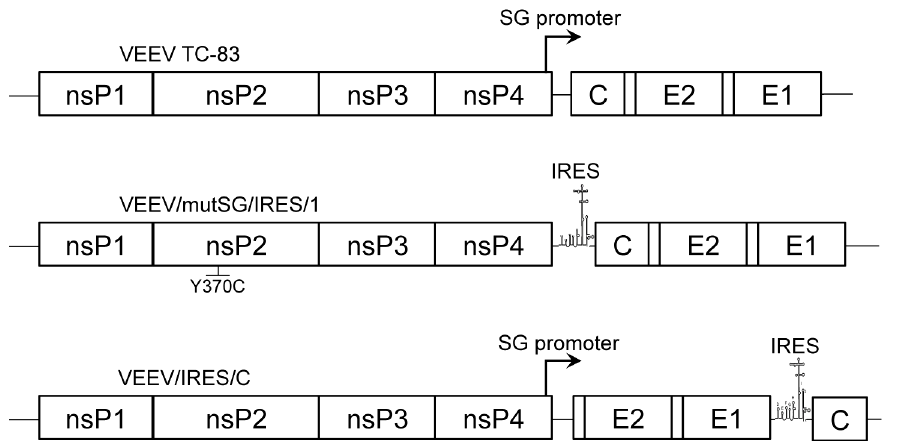
Figure 1. Schematic representation of the recombinant VEEV TC-83/IRES constructs. Alternative positions of the EMCV IRES are indicated. Arrows represent functional subgenomic promoters.